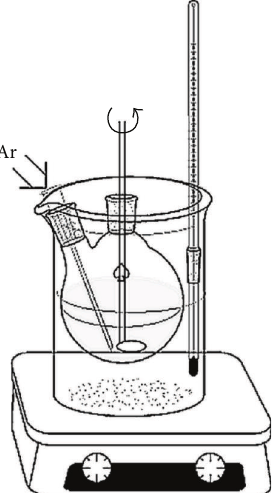
Figure 1: Scheme of reaction installation for EMROP of